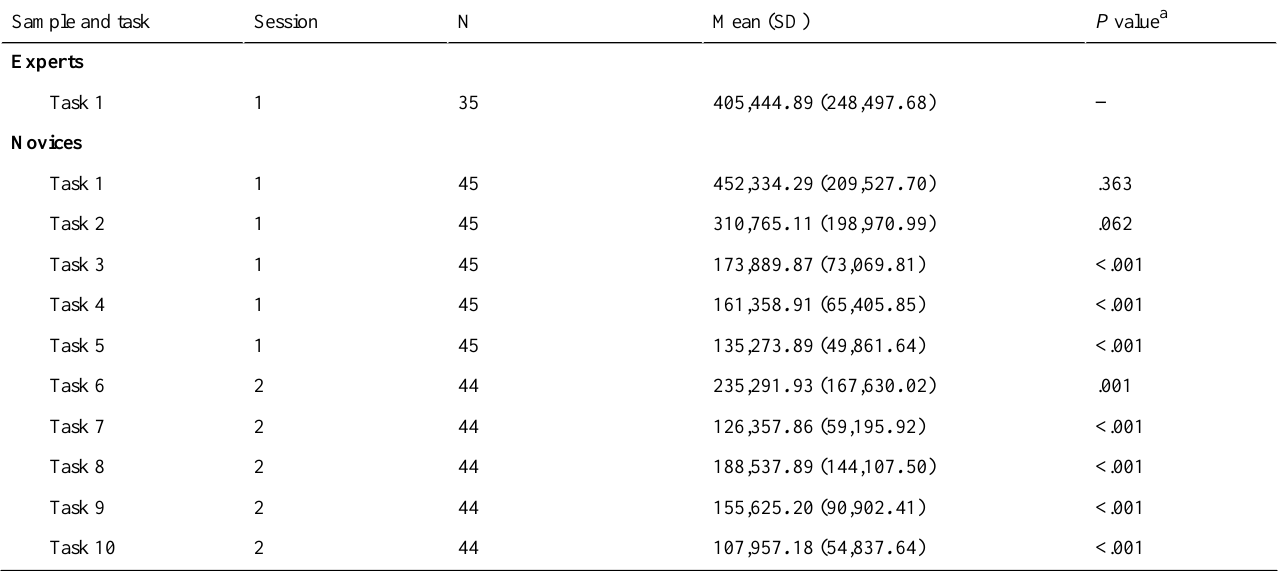
Table 4. Comparisons between the time (in milliseconds) taken by experts at the first task of Session 1 and that taken by novices at each task.